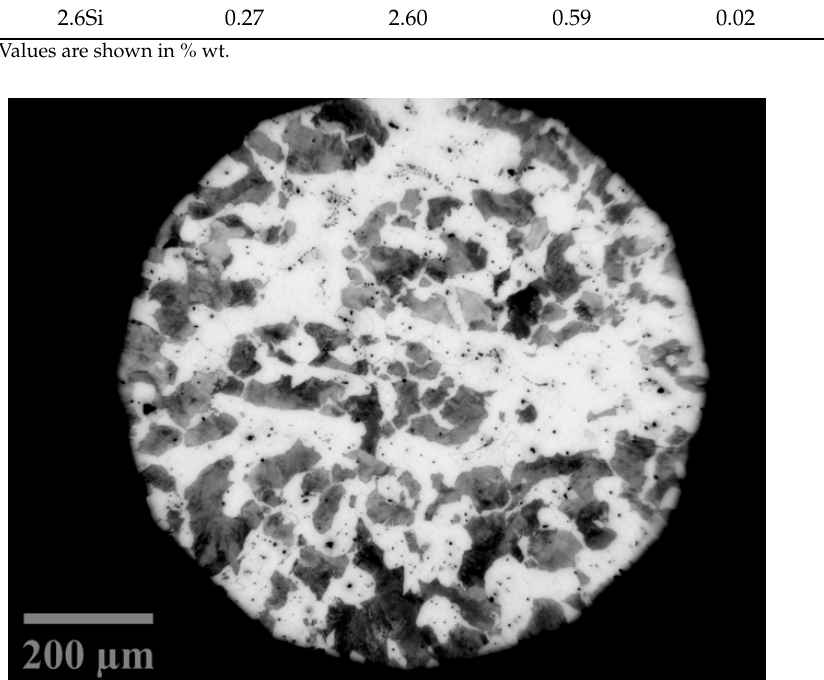
Figure 1. Microstructure of silicon-alloyed steel composed of ferrite (light zones) and pearlite (dark zones) grains, etched with Nital 3. ( dark zones ) grains, etched with Nital